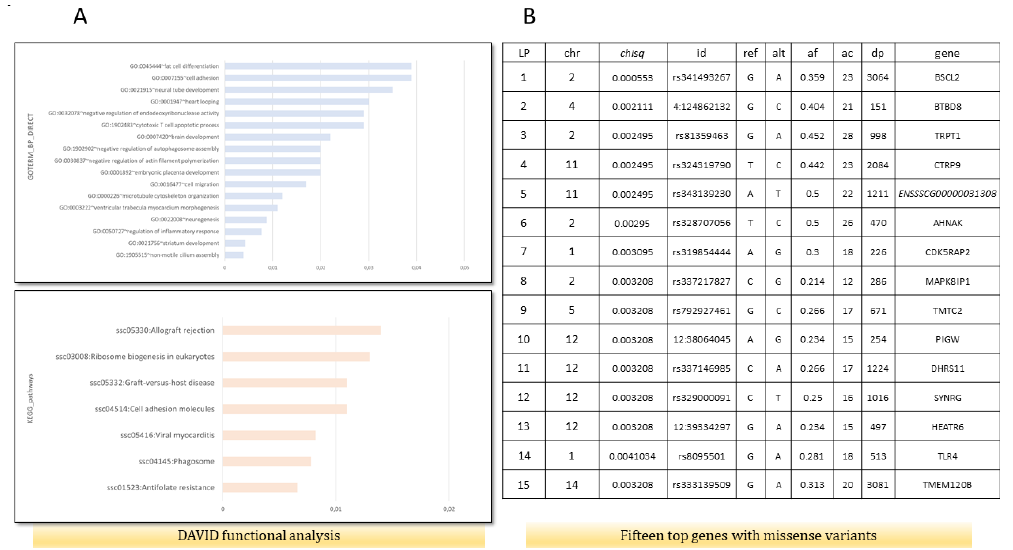
Figure 1. Functional analysis for genes containing missense variants (ms) and genes with the lowest corrected p -value in χ 2 test drawn from variant calling analysis. ( A ) Functional analysis using DAVID, including GO biological process and KEGG pathways on 363 genes with identified missense mutations in fat RNA-seq data. ( B ) Top 15 genes with ms according to χ 2 test. Chr—chromosomal, id—Ensembl number, reference and alternate alleles, af—alternate allele frequency, dp—depth of sequencing, and gene names.